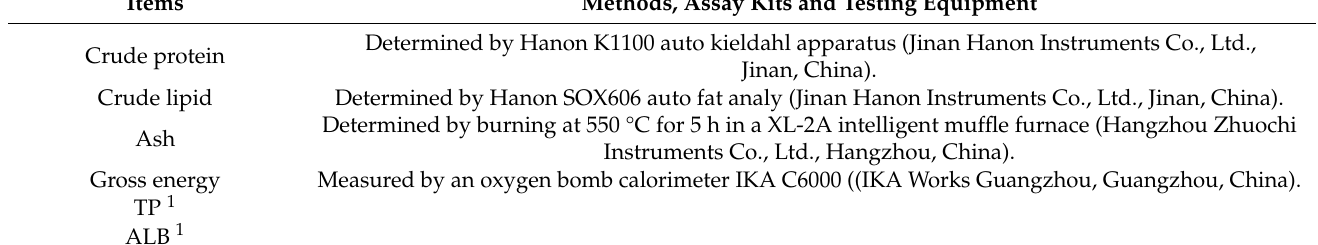
Table 5. The methods and testing equipment of chemical analysis. Methods, Assay Kits and Testing